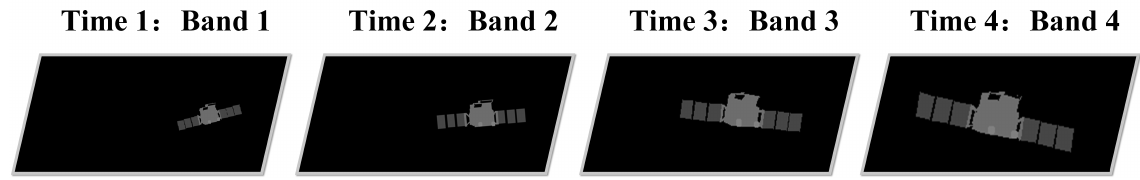
Figure 26. Schematic of staring hyperspectral images with decreasing imaging